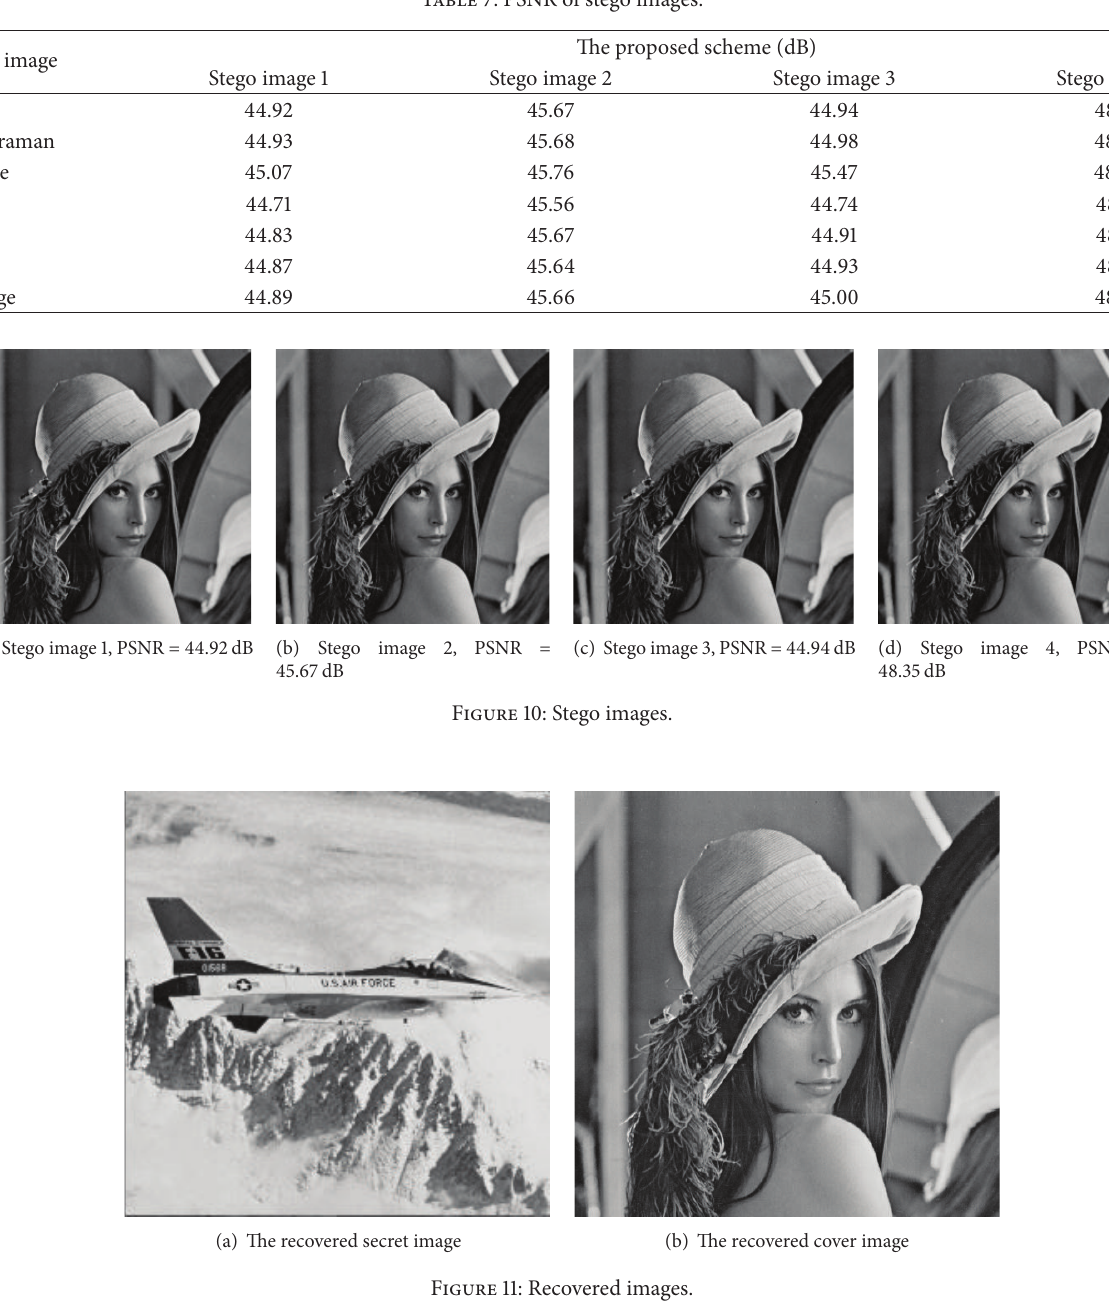
Figure 11: Recovered